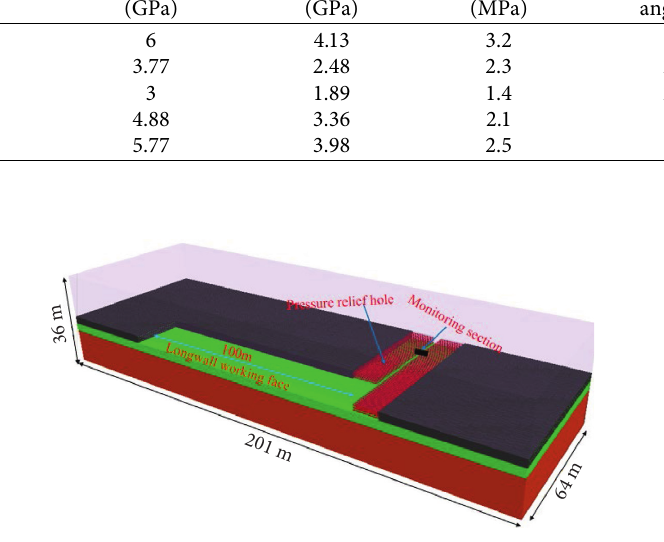
Figure 2: Numerical calculation model.